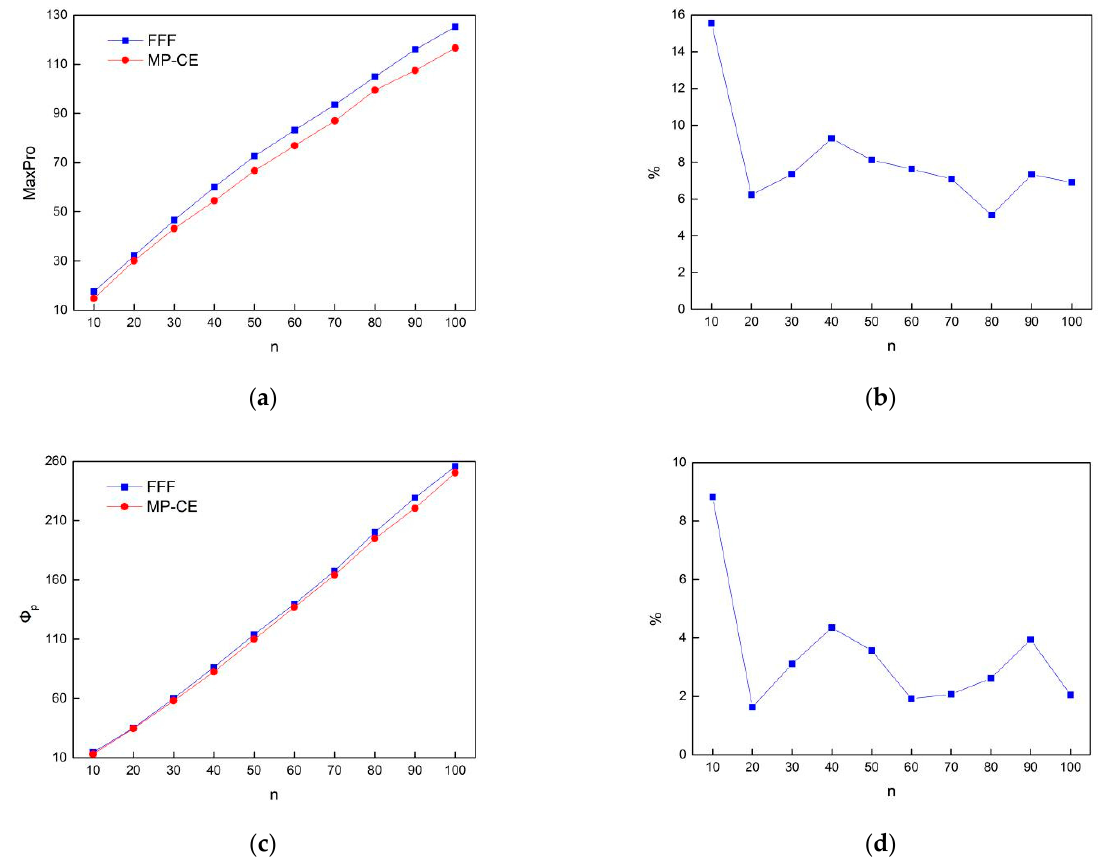
φ ; ( d ) increase percentage of p